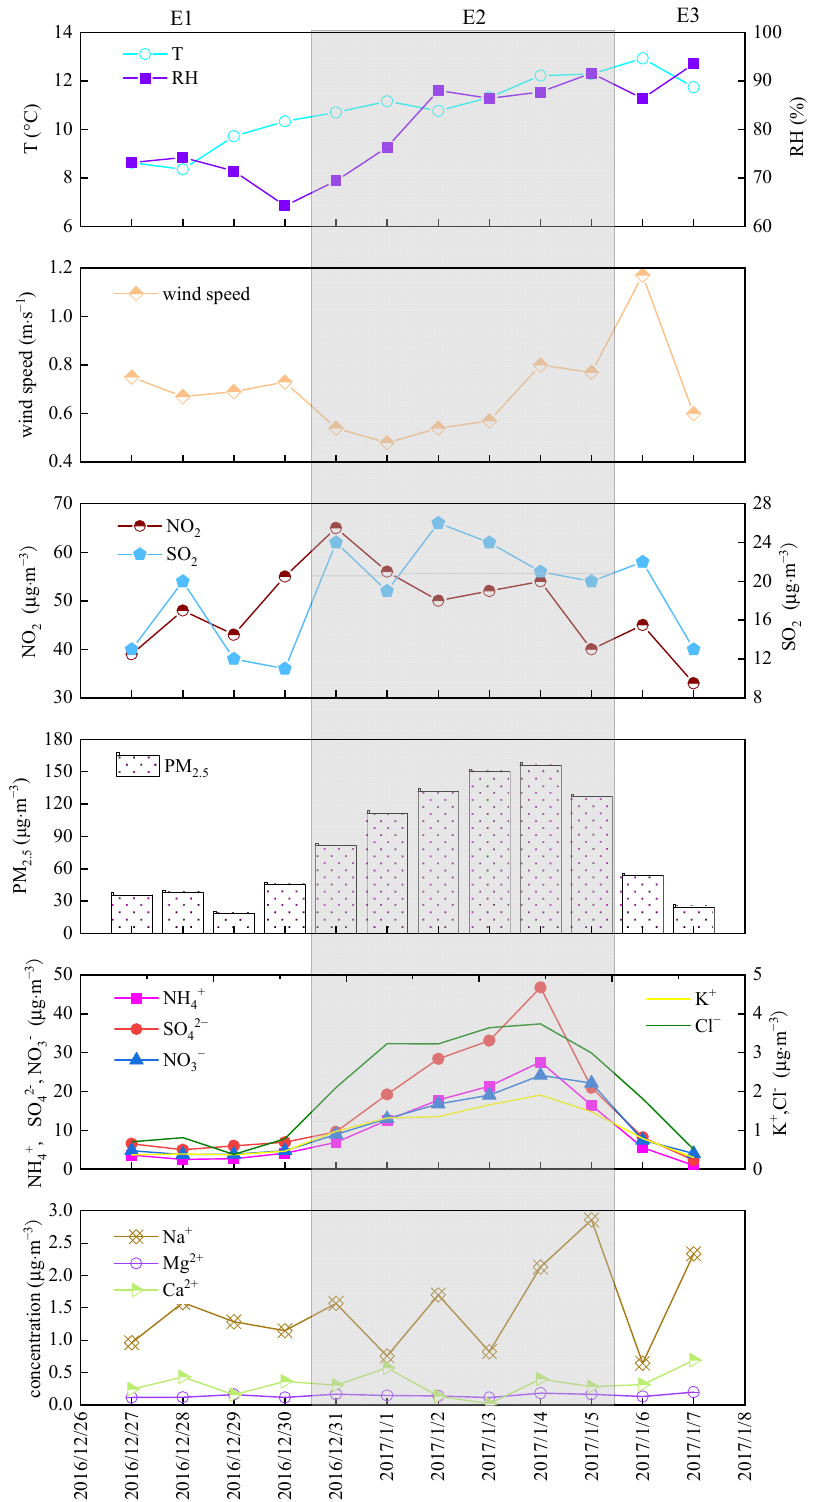
Figure 7. The time series of daily meteorological parameters, gaseous precursors, PM 2.5 , and WSIIs concentrations from 27 December 2016 to 7 January 2017.